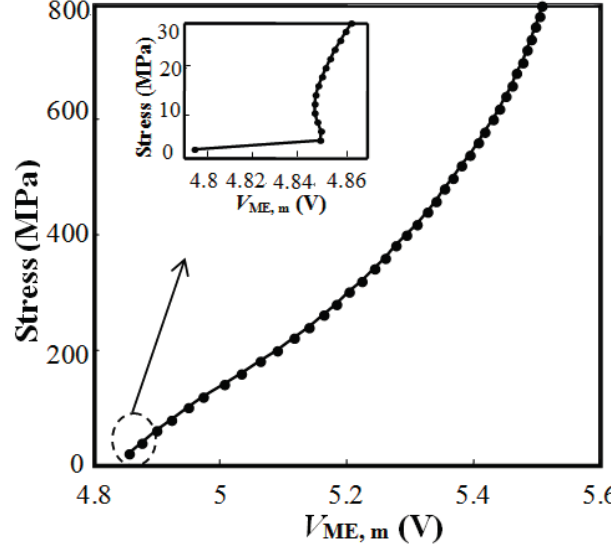
Figure 8. The simulated relationship of stress and V output from the ME sensing